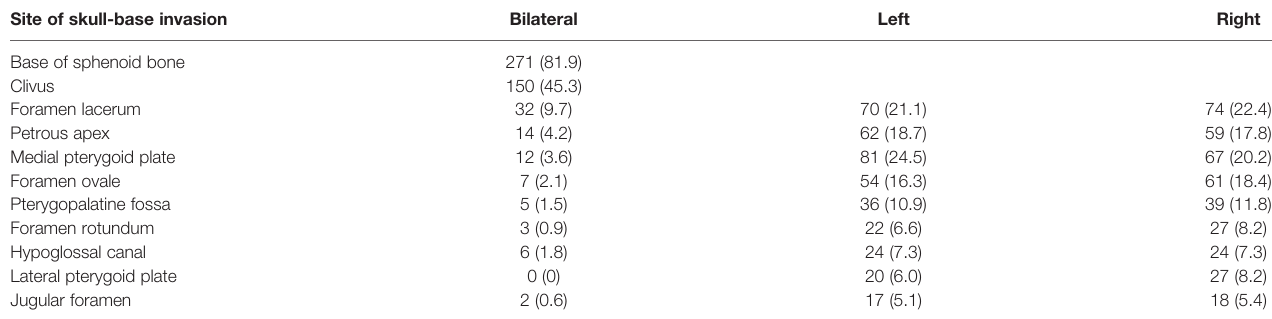
TABLE 5 | Incidence rates of skull-base invasion for nasopharyngeal carcinoma. Site of skull-base invasion